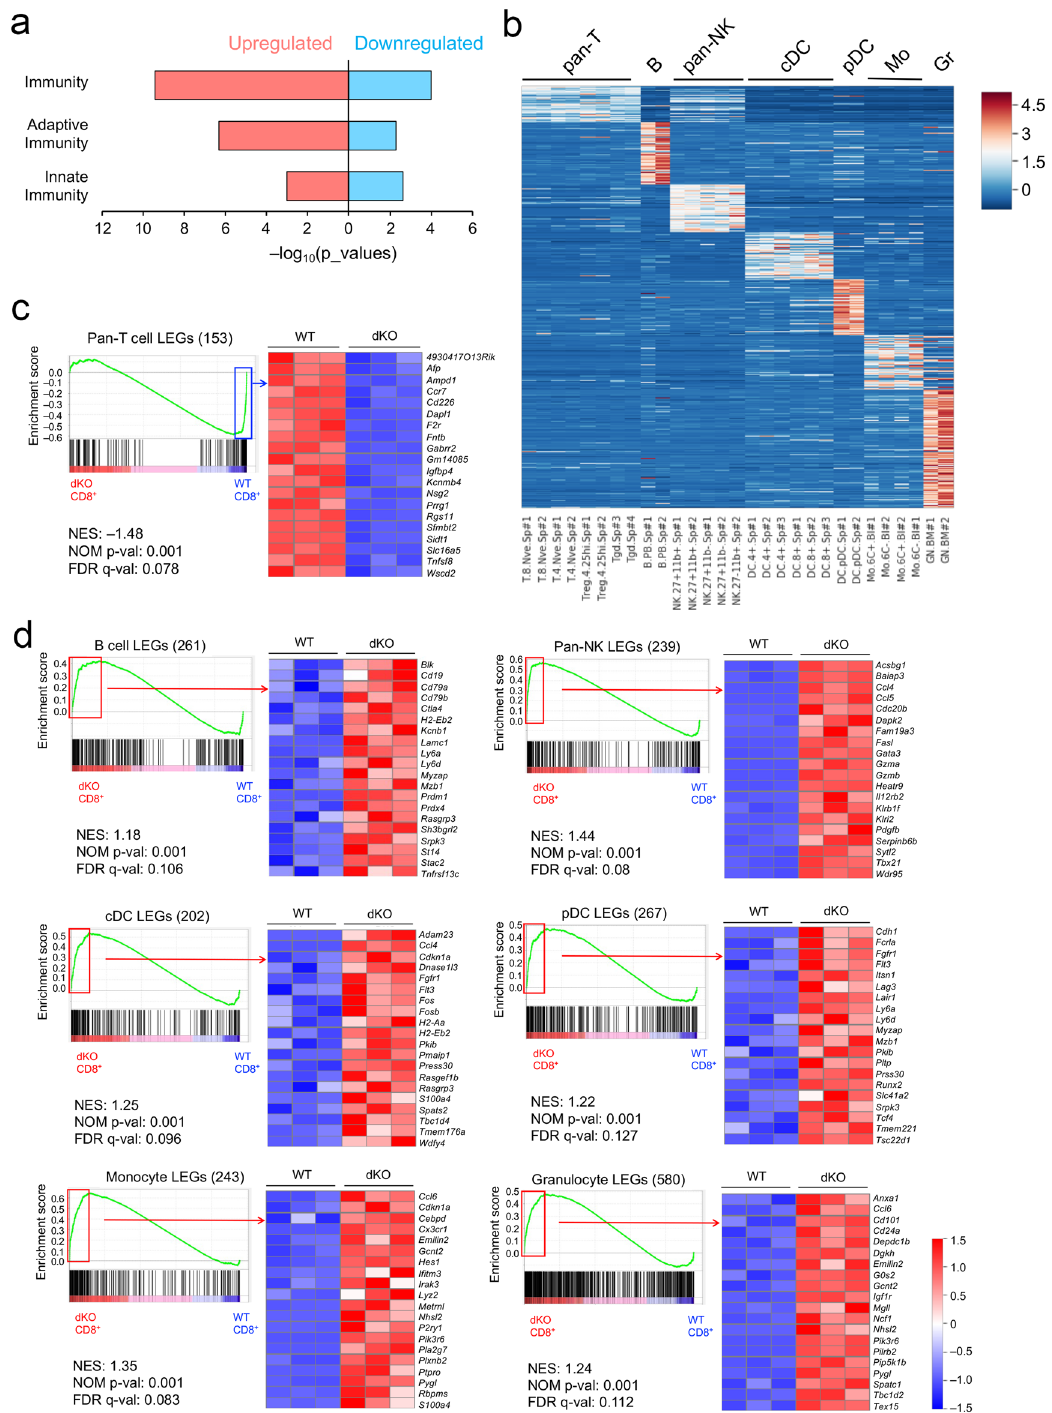
Fig. 4 Tcf1 and Lef1 are required for repressing non-T lineage-enriched genes in mature CD8 + T cells. a Functional annotation of up- and downregulated genes in dKO CD8 + T cells with the DAVID Bioinformatics Resources. The most enriched categories and corresponding p values (output from DAVID) are shown. b Heatmap showing lineage-enriched genes (LEGs) for pan-T, B, pan-NK cells, conventional DC (cDC), plasmacytoid DC (pDC), monocytes (Mo) and bone marrow granulocytes (Gr) based on transcriptomic analysis of multiple immune cell lineages (GSE109125). Color scale represents z-score transformed from expression data. c pan-T cell LEGs are enriched in WT over dKO CD8 + T cells, where 61 of 153 genes are at the leading edge. d non- CD8 + T cell LEGs are enriched in dKO over WT CD8 + T cells, where 89 of 261 B cell LEGs, 83 of 239 pan-NK cell LEGs, 77 of 202 cDC LEGs, 79 of 267 pDC LEGs, 107 of 243 monocyte LEGs, and 167 of 580 granulocyte LEGs are at the leading edge. For all GSEA, enrichment plot for each gene set is shown, and also marked are NES (normalized enrichment score), NOM p val (nominal p values), and FDR q-val (false discovery rate q values) as output from GSEA. Red and blue rectangles mark genes in the leading edge, enriched in WT and dKO CD8 + T cells, respectively. Top enriched genes in each set are shown in